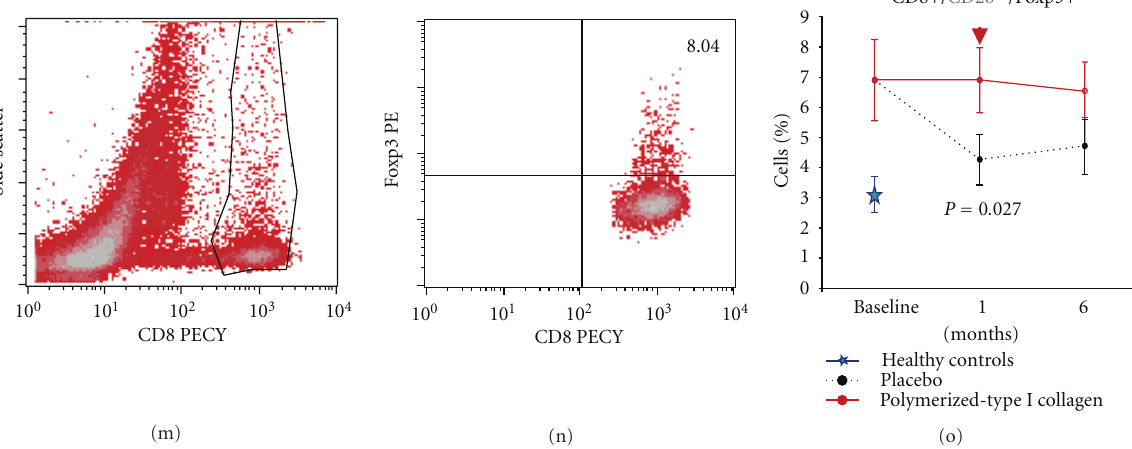
Figure 2: Percentage of CD14-derived proinflammatory cytokine in OA knee patients. (a) An electronic gate was made for CD4 − /CD14+ single positive cells. (b) From the gate a CD4 − /CD14+/IL-1 β + cells were determined. (c) Percentage of CD4 − /CD14+/IL-1 β + peripheral blood cells was established at baseline, 3, and 6 months. (d) An electronic gate was made for CD4 − /CD14+ single positive cells. (e) From the gate d CD4 − /CD14+/TNF- α + cells were determined. (f) Percentage of CD4 − /CD14+/TNF- α + peripheral blood cells was established at baseline, 3, and 6 months. (g) An electronic gate was made for CD4 − /CD14+ single positive cells. (h) From the gate f CD4 − /CD14+/IL- 10+ cells were determined. (i) Percentage of CD4 − /CD14+/IL-10+ peripheral blood cells was established at baseline, 3 and 6 months. (j) An electronic gate was made for CD4+/CD14 − single positive cells. (k) From the gate j CD4+/CD14 − /Foxp3+ cells were determined. (l) Percentage of CD4+/CD14 − /Foxp3+ peripheral blood cells was established at baseline, 3, and 6 months. (m) An electronic gate was made for CD8+/CD28 − single positive cells. (n) From the gate m CD8+/CD28 − /Foxp3+ cells were determined. (o) Percentage of CD8+/CD28 − / Foxp3+ peripheral blood cells was established at baseline, 3, and 6 months. The software employed was CellQuest (BD Biosciences). A total of 50,000 events were recorded for each sample. Results are expressed as mean ± SE. ∗ P < 0 . 05.